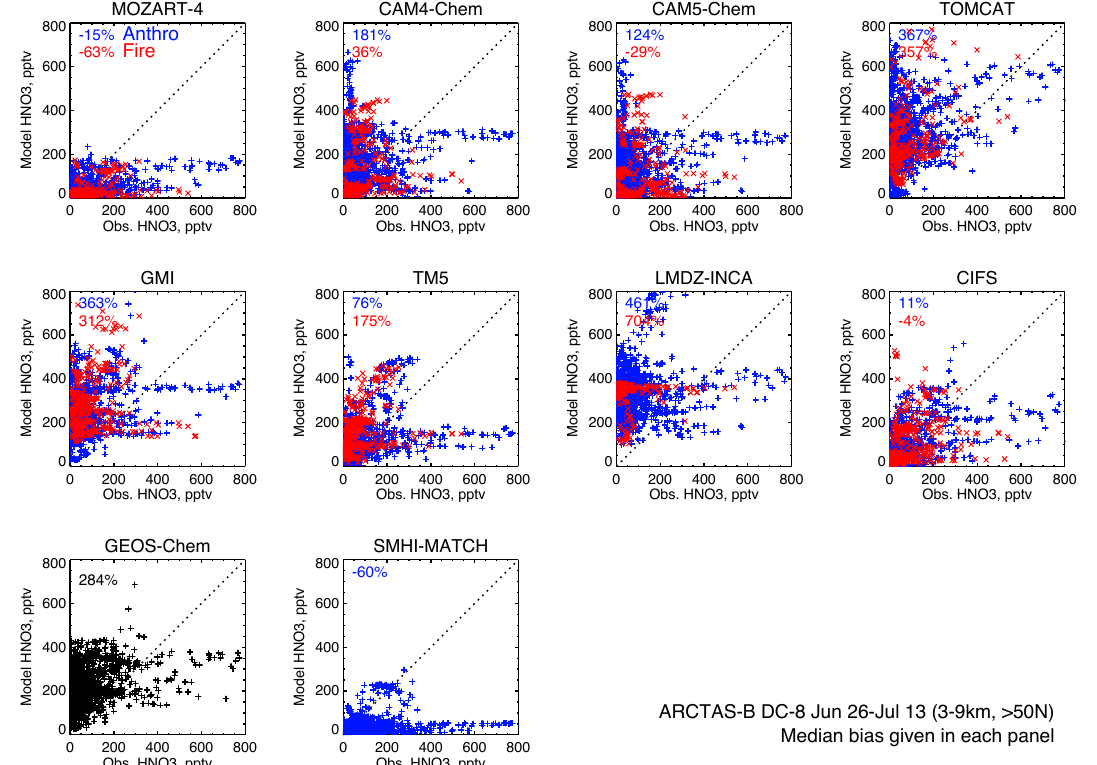
Figure 4. As Fig. 1, but for HNO 3